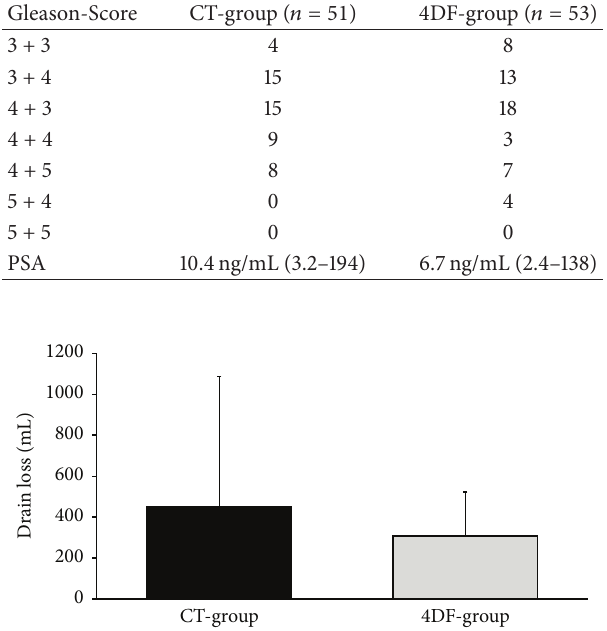
Figure 2: Drain loss (mean) of CT-group versus 4DF-group.